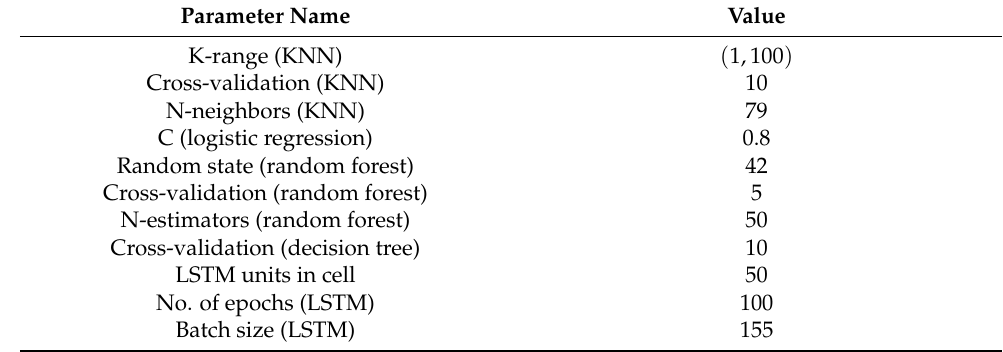
Table 1. Summary of experiment